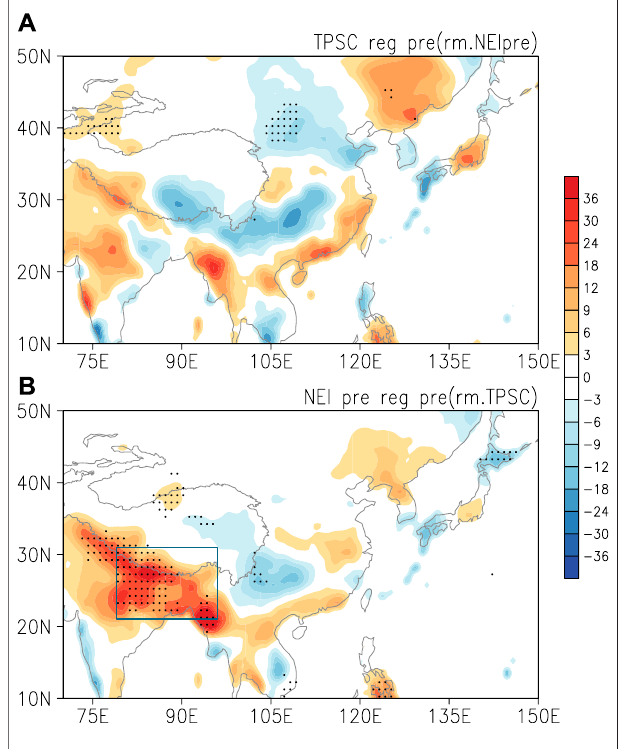
FIGURE 7 | Anomalies of summer precipitation (pre) (mm/month) obtained by linearregression against the (A) western Tibetan Plateausummer snow cover index and (B) northeast Indian summer precipitation index for the period 2002 — 2020 with the (A) northeast Indian summer precipitation signal and (B) western Tibetan Plateau summer snow cover signal removed. The dotted regions in (A) and (B) denote anomalies signi fi cant at the 95% con fi dence